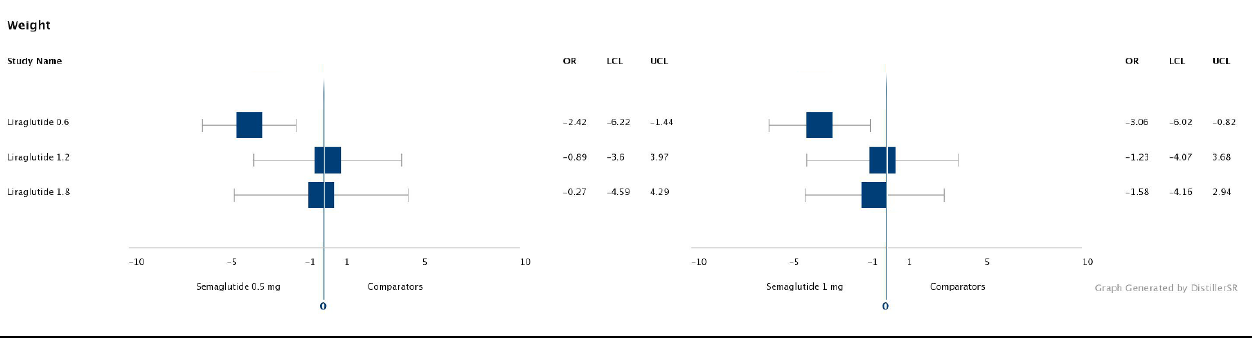
forest plots for a change from baseline in weight. OR = treatment difference, LCL and UCL = lower and upper credible intervals (95% Crl) for mean treatment effect. Treatment differences are considered significant when the 95% CrI excludes 0. NMA = network meta-analysis.